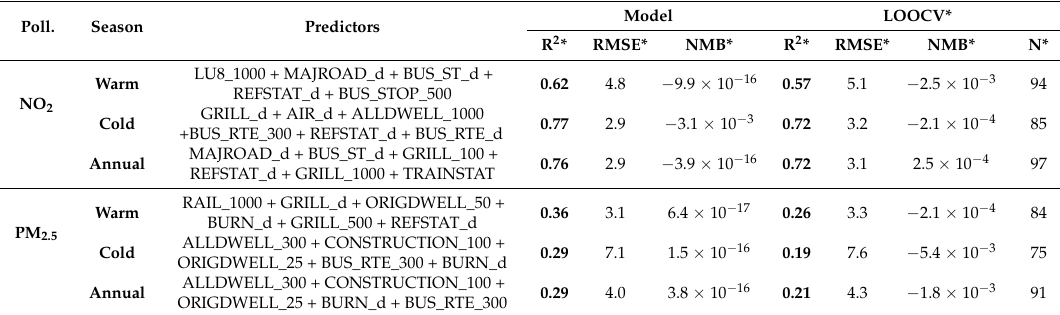
Table 2. Description of the NO 2 and PM 2.5 final models for each season based on the three study areas. Includes the list of best predictors, models’ summary statistics, and validation’s